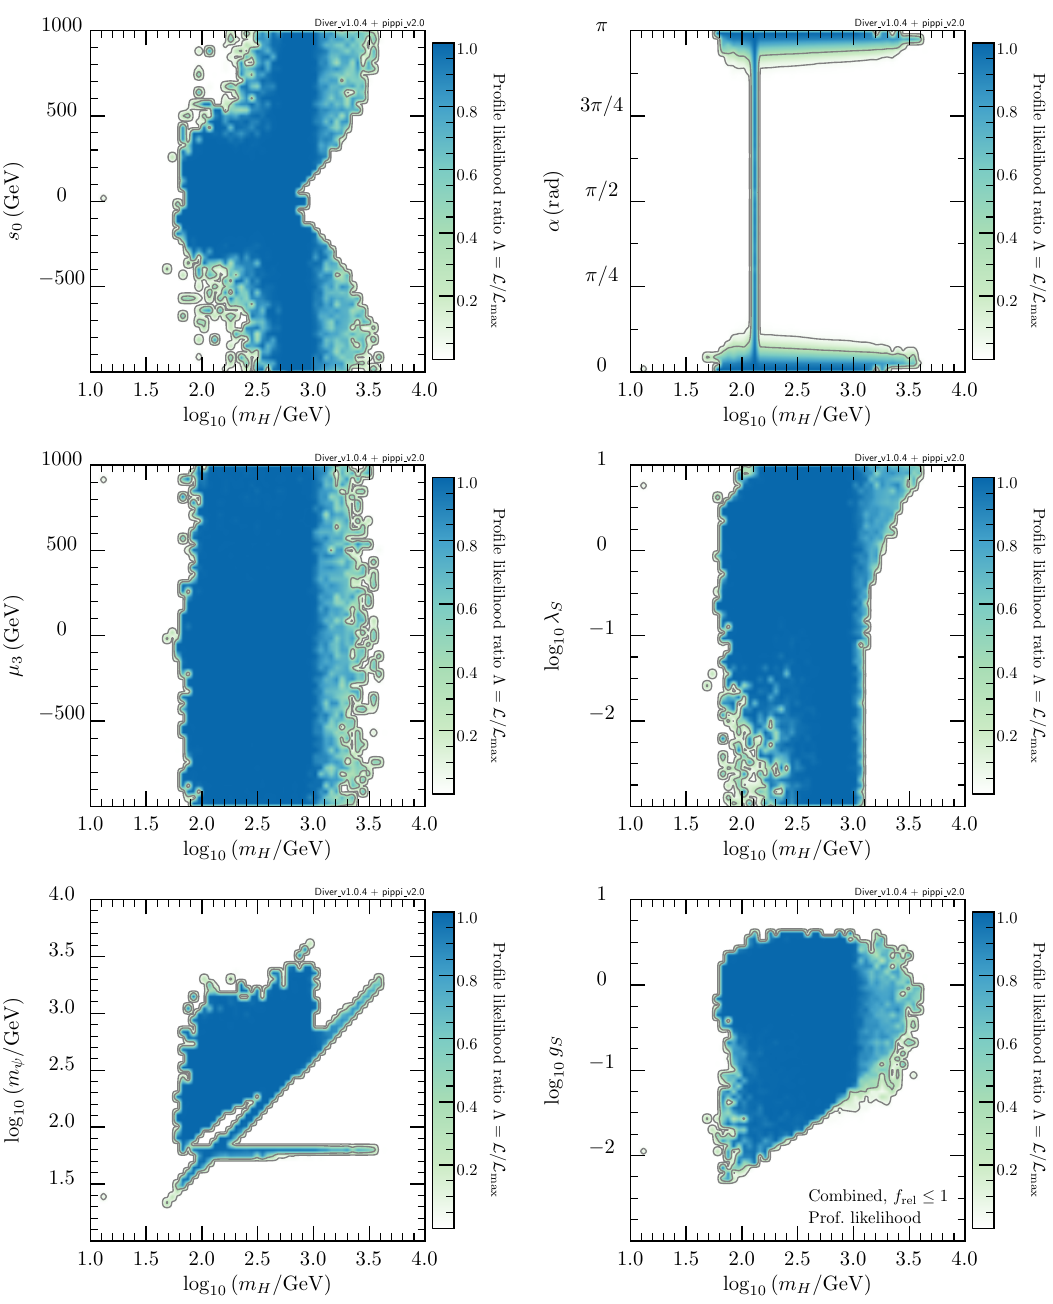
Figure 4 . 2D PL plots from a global (cid:12)t of our model assuming f rel (cid:17) (cid:10) = (cid:10) DM (cid:20) 1. The contour lines mark out the 1 (cid:27) (68.3%) and 2 (cid:27) (95.4%) C.L. regions. 2. ( m H ; (cid:11) ) plane: we see that the model is allowed by all constraints for a range of low and high m H values provided (cid:11) 0 ; (cid:25) . This is expected as the second scalar H ’